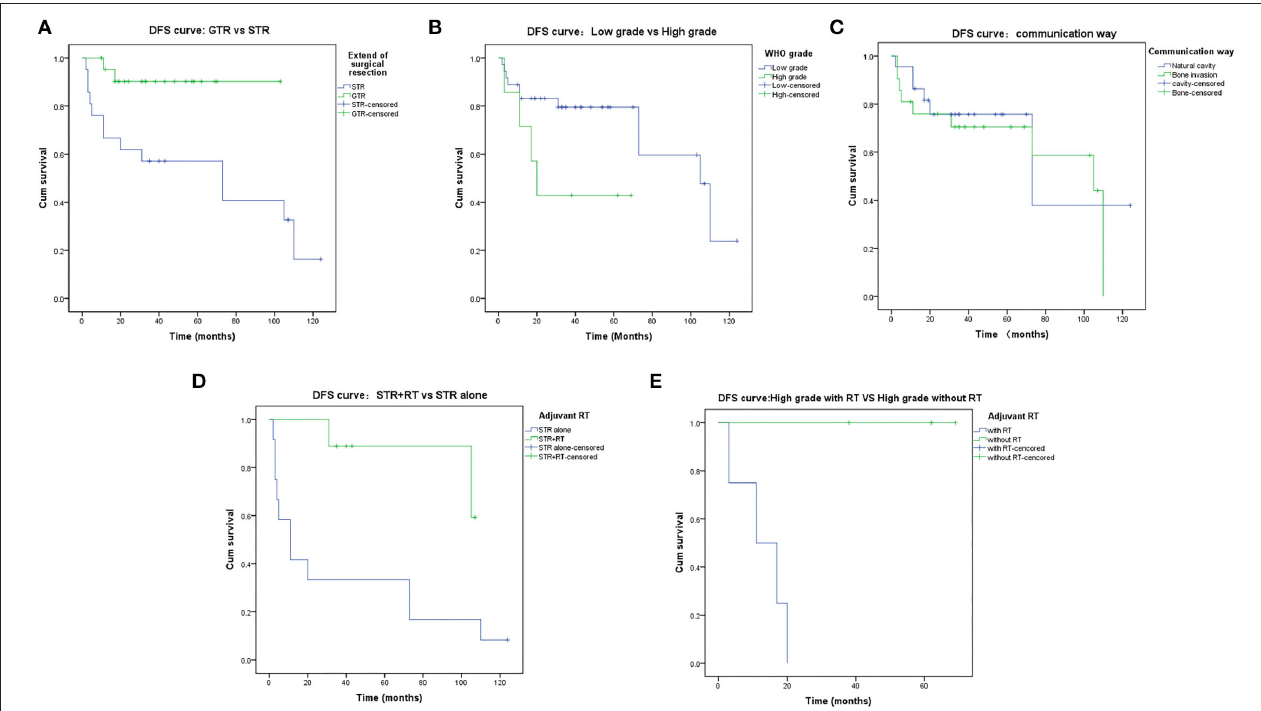
FIGURE 3 | Disease-Free-Survival rates. (A) DFS of the extent of resection: GTR vs STR. (B) DFS of the WHO grade: Low grade vs. High grade. (C) DFS of the communication way: Natural cavity vs. Destruction of Bone. (D) DFS of the STR: STR + RT vs. STR alone. (E) DFS of the high-grade meningiomas: with adjuvant RT vs. without adjuvant